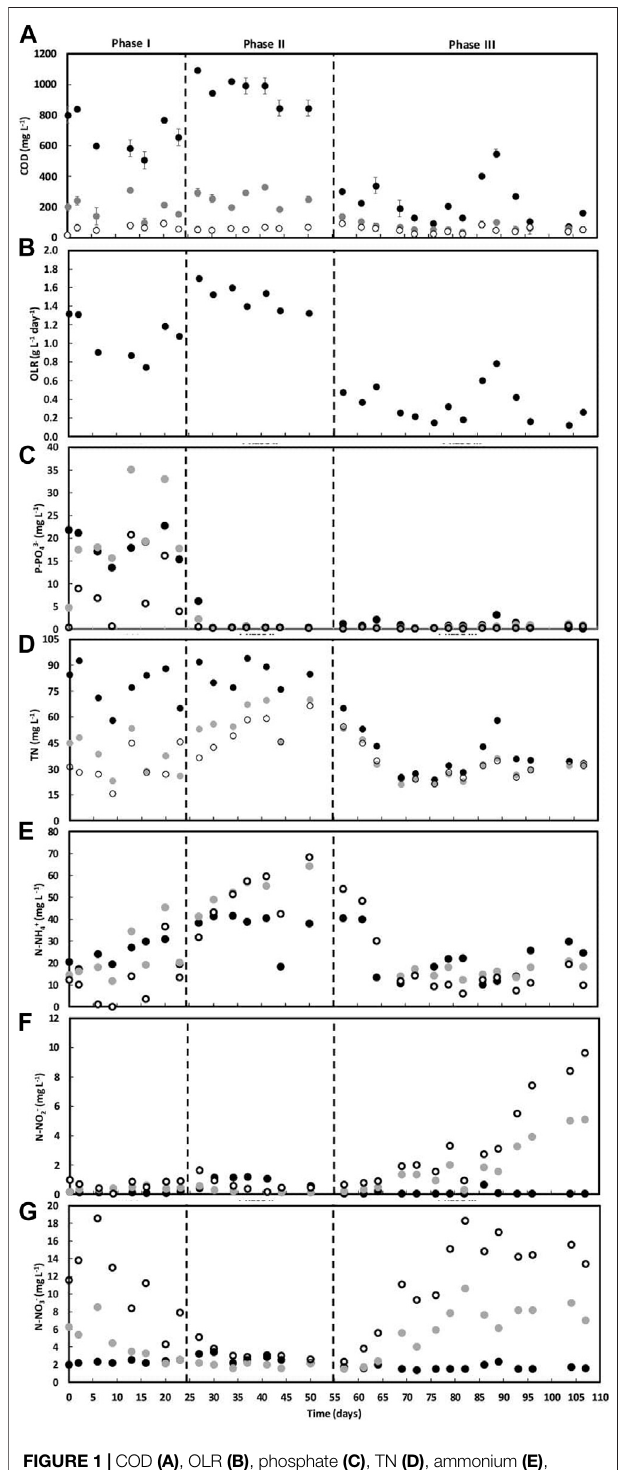
FIGURE 1 | COD (A) , OLR (B) , phosphate (C) , TN (D) , ammonium (E) , nitrite (F) , and nitrate (G) concentrations along AGS-SBR operation. Concentration in thewastewater ( C ) , in thereactorbulkliquid after anaerobic feeding ( C ) and outlet ( ○ ) are